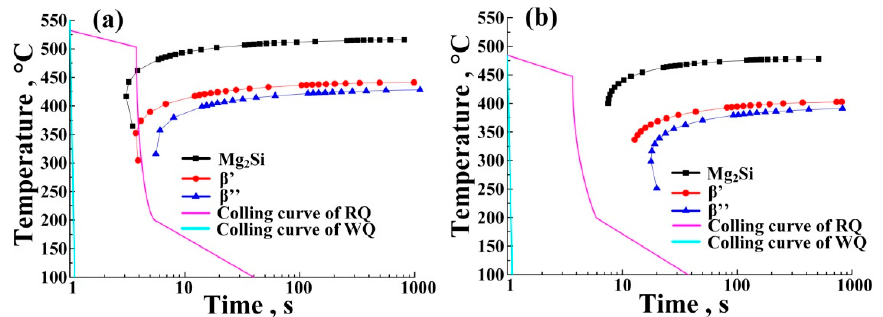
Figure 8. Continuous cooling transformation (CCT) curve of 6061 aluminum alloy at different solution temperature: ( a ) 540 °C; ( b ) 490 °C.